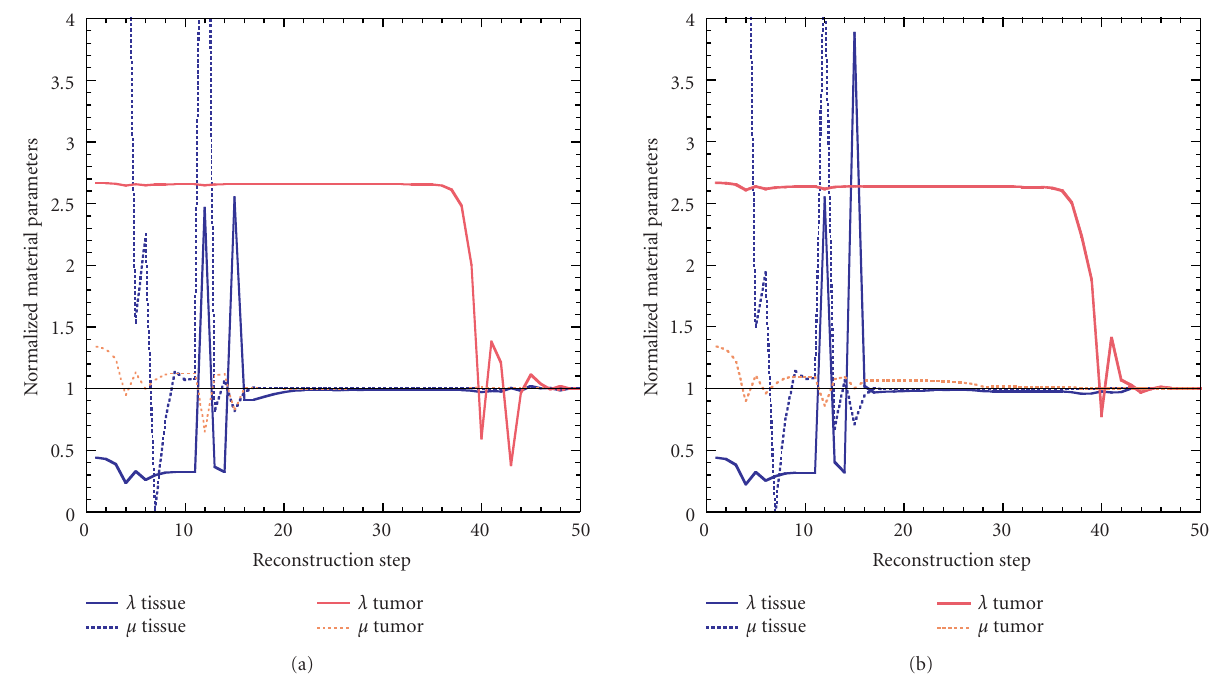
Figure 7: Convergent loci of elasto-mammography reconstruction for Lam´e parameters ( λ , μ ) of normal breast tissue and tumor, normalized with the exact values correspondingly. No measurement error is considered. (a) Phantom I (one tumor); (b) Phantom II (two